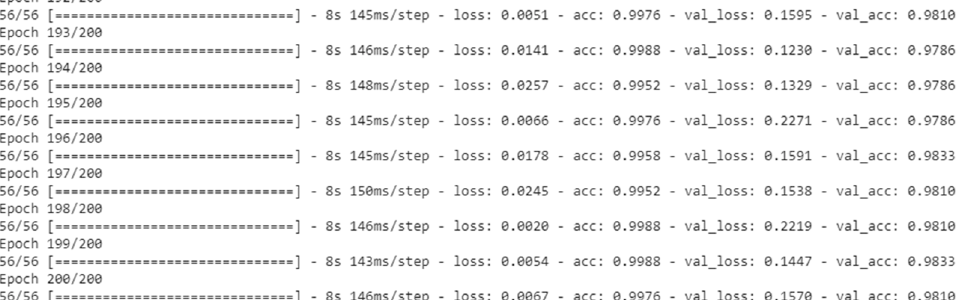
Figure 5. Showing ResNet50 training process using fine-tuning .